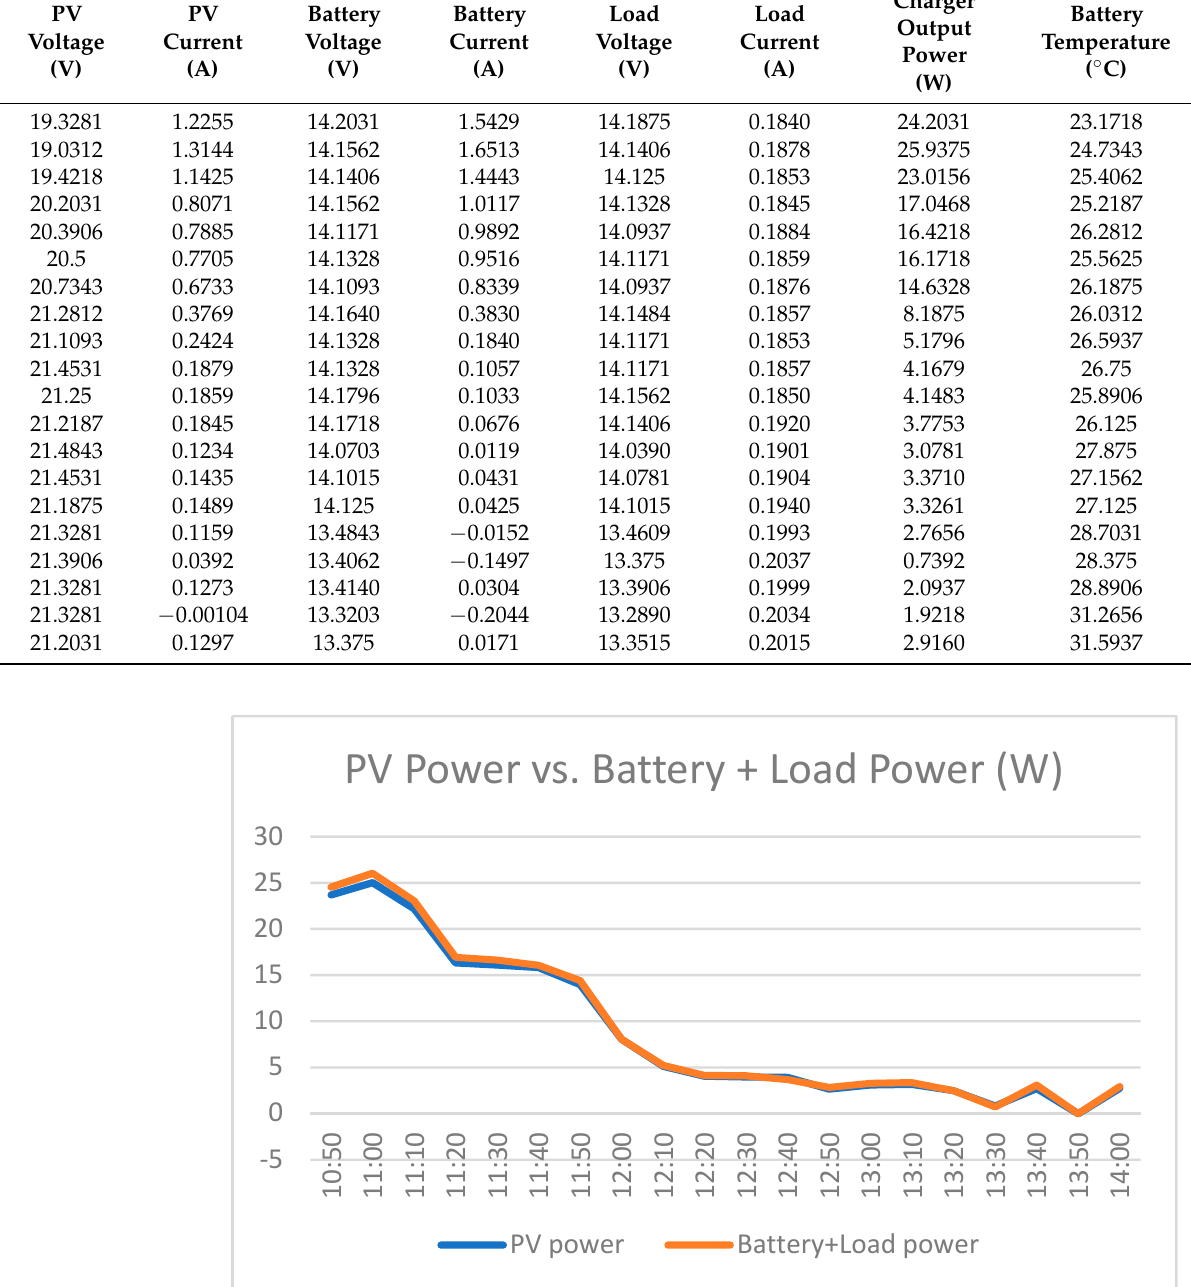
Figure 9. Battery Voltage Decreasing After Fully Charged. In addition to the data in Table 3, the MPPT charge controller was also able to retrieve the following values: heatsink temperature, ambient temperature, charge state, load state, PV voltage at maximum power, PV maximum output power, PV open circuit voltage, maximum battery voltage (daily), minimum battery voltage (daily), time in absorption (daily), time in equalization (daily), and time in float (daily). The data enabled remote